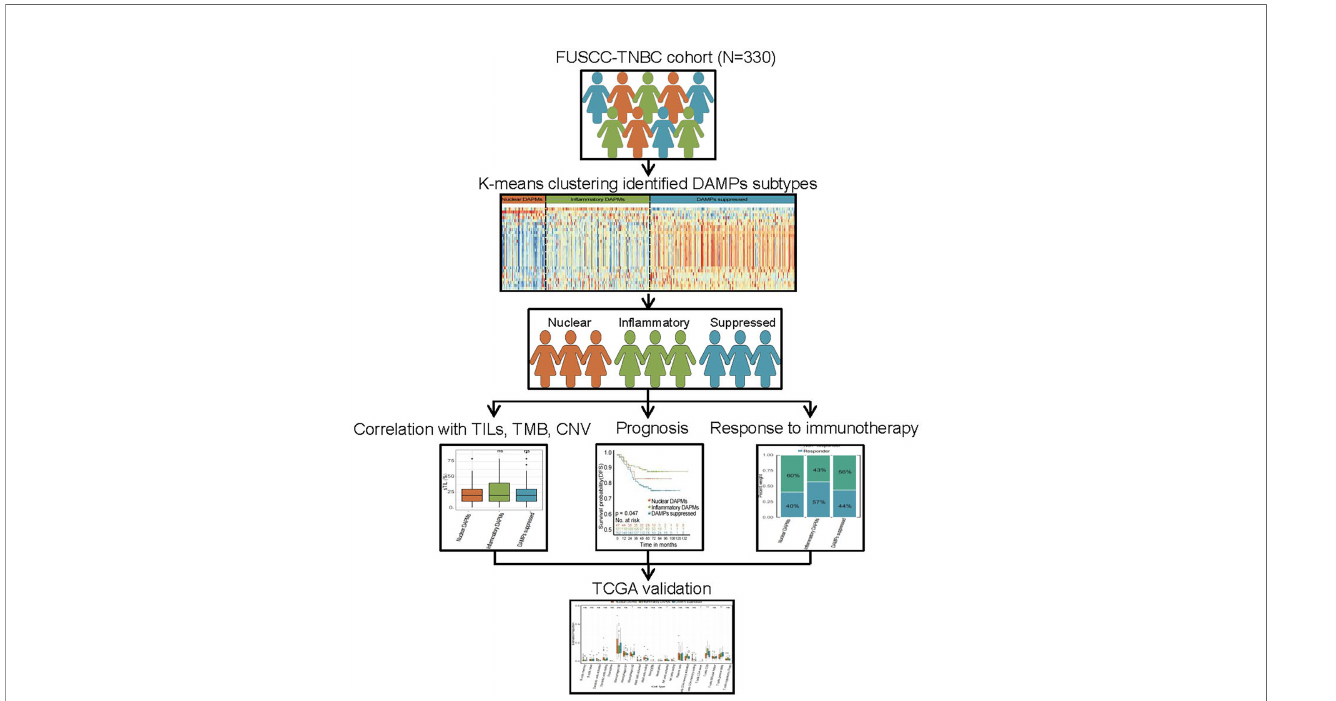
FIGURE 1 | Flow chart of the data analysis process. The DAMPs-associated subtypes were established based on 330 TNBCs from the FUSCC cohort and validated in the TCGA cohort. DAMPs, damage-associated molecular patterns; FUSCC, Fudan University Cancer Center; TCGA, The Cancer Genome